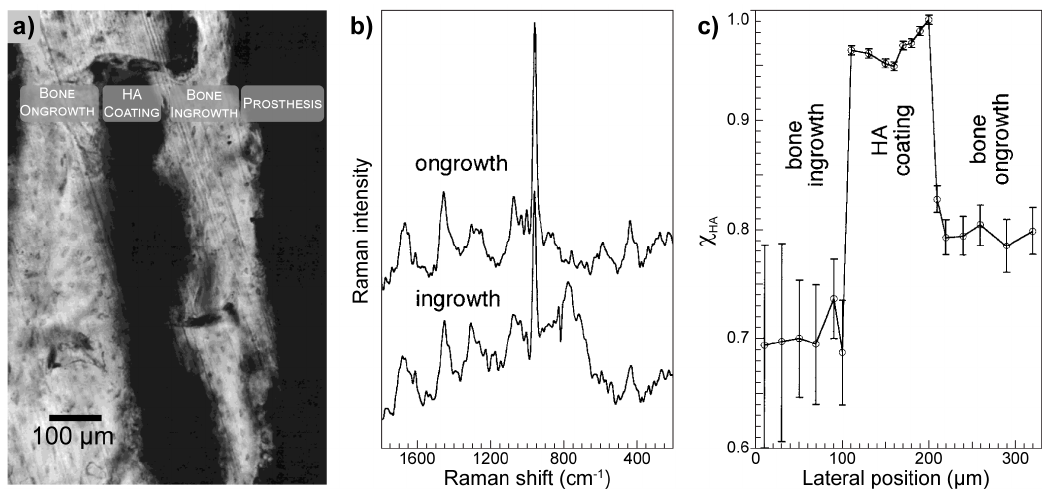
Figure 13. Canine specimen: ( a ) microscopic section of a coated implant, eighteen months after implantation. Grey parts of the image represent bone tissue, while the hydroxyapatite (HA) coating and the prosthesis are in black, ( b ) Raman spectra of the ongrowth and ingrowth part of the bone and ( c ) hydroxyapatite content ( Χ HA ) at different lateral positions. Figure adapted with permission from [92].